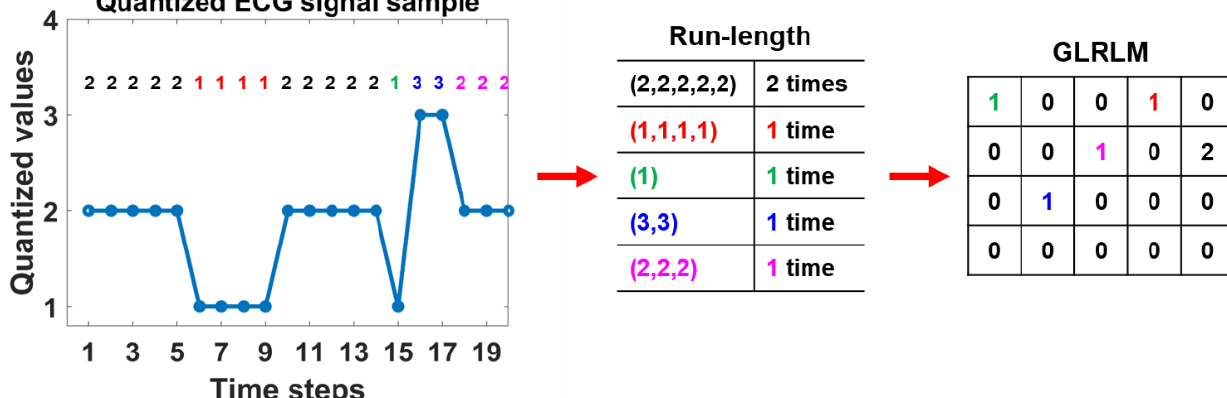
Figure 3. The process of generating the GLRLM for a quantized ECG signal. Table 3. GLRLM features. 𝑄(𝑖, 𝑗) is the GLRLM representing the number of runs of quantized gray level 𝑖 and consecu- tive length 𝑗 . 𝑁 𝑟𝑢𝑛 is the number of runs of the GLRLM and 𝑁 𝑝 is the total signal length. 𝜇 𝑖 = ∑ ∑ 𝑖 ∗ 𝑞 𝑗𝑝 ∑ ∑ 𝑗 ∗ 𝑄(𝑖,𝑗) . 𝑖 𝑁 𝑟𝑢𝑛